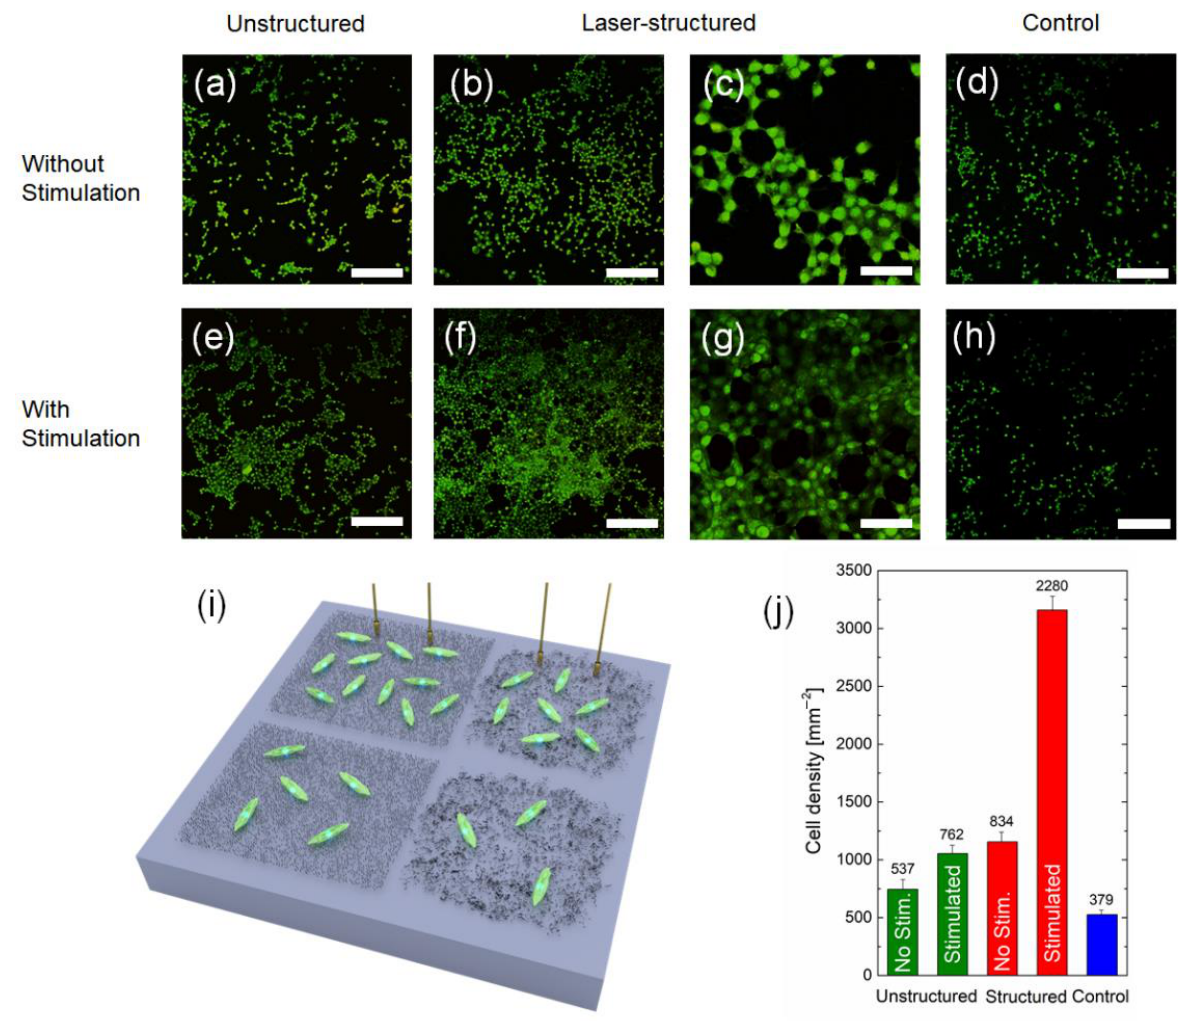
Figure 6. Examples of fluorescence microscope images of fibroblast cell cultures on Si substrates 24 h in vitro with unstructured ( a , e ) and laser-structured ( b , c , f , g ) MWCNT arrays with BSA immobilized with ( e – g ) and without ( a – c ) electrical stimulation and control samples ( d , h ). The scale bar for ( a , b , d , e , f , h ) is 200 µm, for ( c , g ) it is 50 µm. Schematic of fibroblasts grown on Si substrates with various conditions used in the experiment ( i ). The values on the bars in ( j ) represent the total number of live cells averaged over several areas of size 850 µm × 850 µm (0.7225 mm 2 ). The results from three images on three different samples for each type of the condition were averaged for the statistics; n = 9.